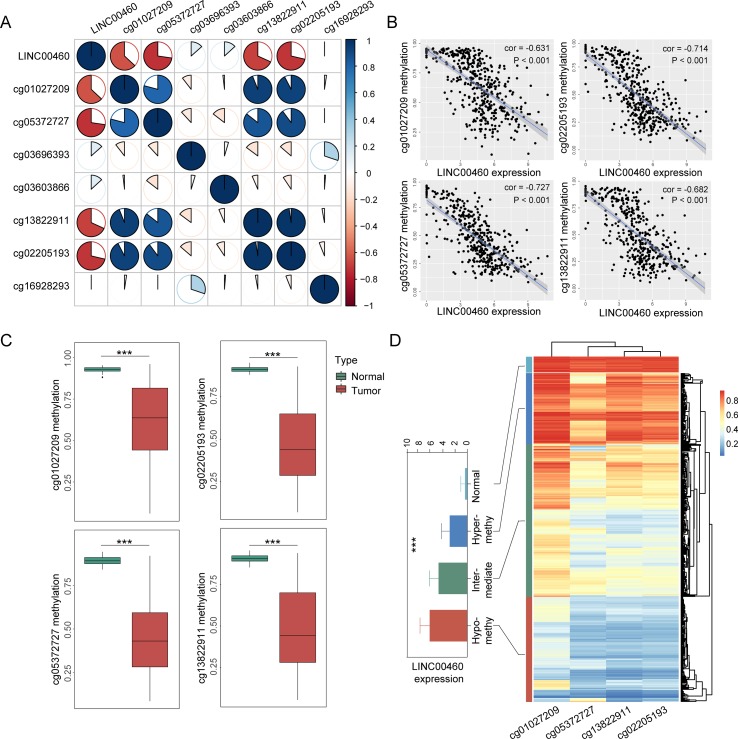
CpG island methylation of LINC00460. (A) Correlation between seven CpG methylation islands and LINC00460 expression screened from TCGA database. (B) Four islands showing a significant negative correlation with LINC00460 expression. (C) CpG island methylation statue between tumor and normal. (D) Heatmap of four CpG sites methylation in LINC00460 promoter. Three subgroups were identified by hierarchical clustering analysis in tumor. The DNA methylation in normal tissue is shown as the control. ***p < 0.001.